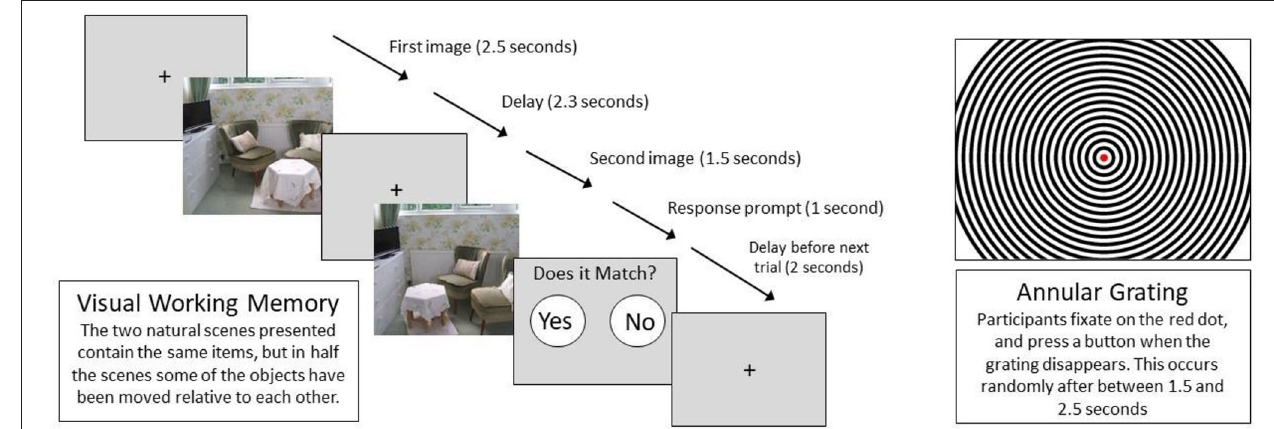
FIGURE 2 | Visual